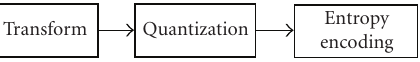
Figure 2: Block diagram of